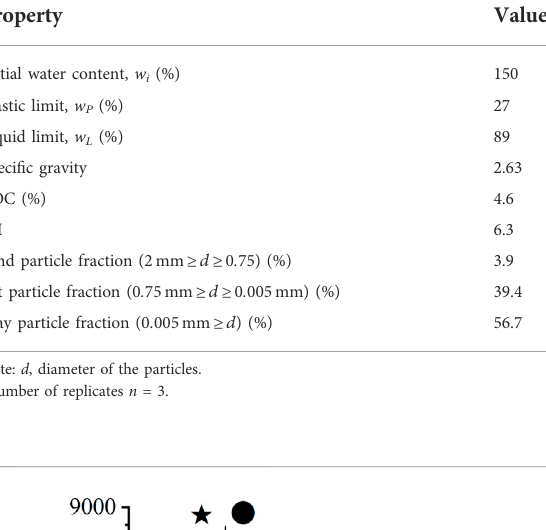
TABLE 1 Physical and chemical parameters of the sediments.